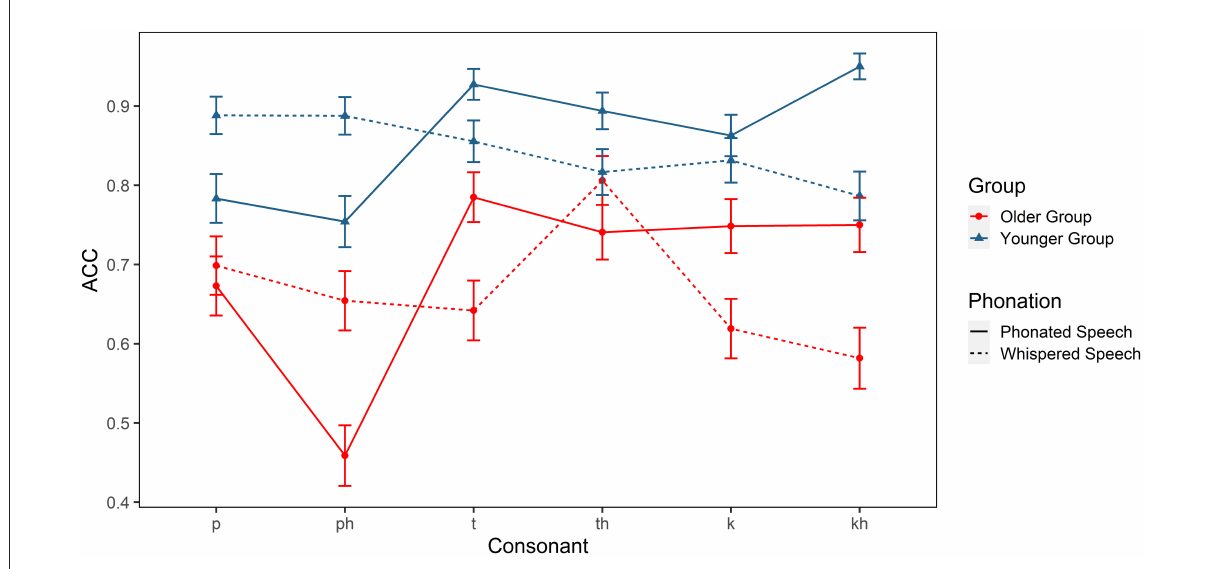
FIGURE4 Identification accuracy of the Mandarin plosives (/p, p h , t, t h , k, k h /) in older and younger listeners.